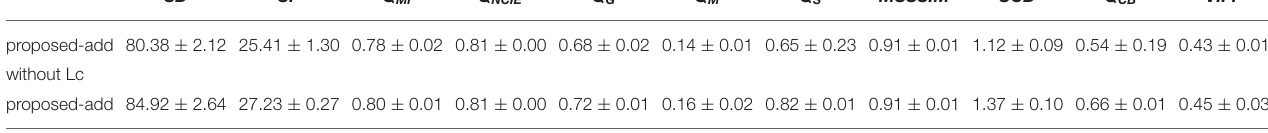
The results of the proposed method are shown as average